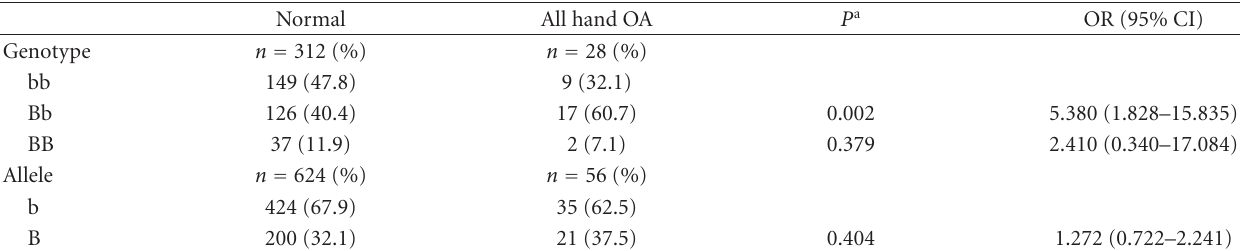
Table 6: Genotype and allele frequencies and odds ratios of MATN3 SNP6 (rs8176070) in control, hand OA cases. Normal All hand OA P a OR (95%